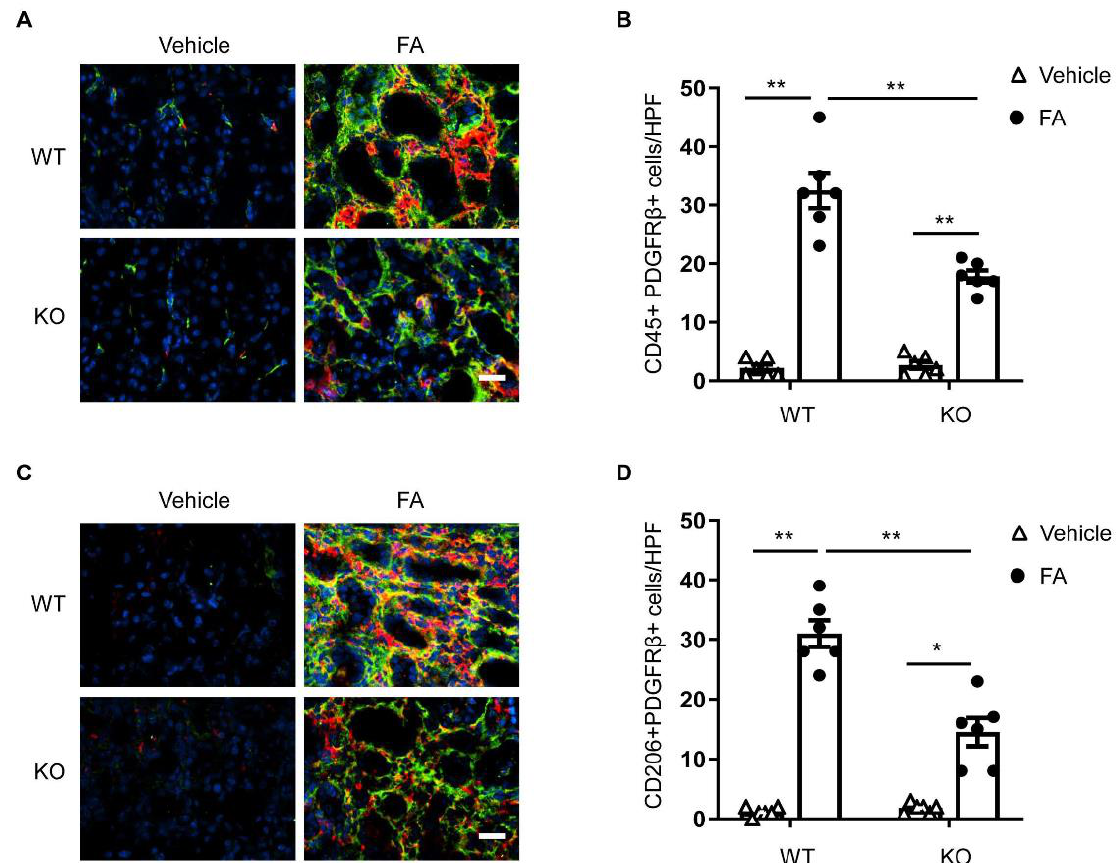
Figure 2. STAT6 deficiency attenuates myeloid fibroblast accumulation and macrophage polarization in folic acid nephropathy. ( A ) Representative photomicrographs of kidney sections from WT and STAT6 KO mice at 2 weeks after vehicle or folic acid treatment immunostained for CD45 (red), PDGFR- β (green), and DAPI (blue). Scale bar, 50 μm. ( B ) Quantitative analysis of PDGFR- β -positive and CD45-positive fibroblasts in kidneys. ** p < 0.01. n = 6 per group. ( C ) Representative photomicrographs of kidney sections immunostained for CD206 (red), PDGFR- β (green), and DAPI (blue). Scale bar, 50 μm. ( D ) Quantitative analysis of PDGFR- β -positive and CD206-positive fibroblasts in kidneys. ** p < 0.01; * p < 0.05. n = 6 per group.